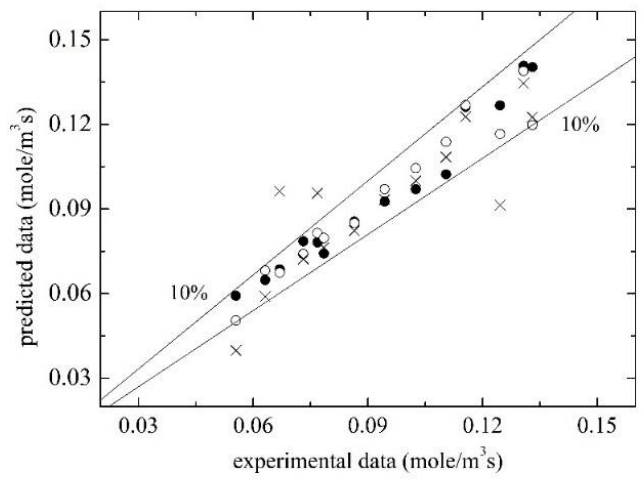
Figure 9. Relationship between experimental and predicted mass transfer coefficient. (●: predicted by Equation (5); ◯ : predicted by Equation (7); ✕ : predicted by Equation (9)). Finally, the mass transfer data in the literature [13] were used to test the mass transfer